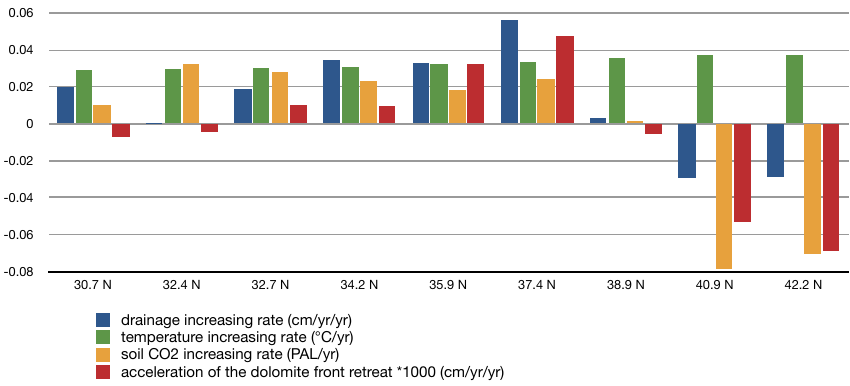
Fig. 8. Increasing rates of vertical drainage (below the root zone), ground temperature, and soil CO 2 level over the Mississippi transect, simulated for the 1950–2100 period. In red, acceleration of the dolomite retreat rate along the transect simulated over the same period. The dolomite front is moving downwards at each location, but this retreat rate either accelerates (positive value) or decelerates (negative value). Maximum acceleration of the retreat rate is reached in the central section of the Mississippi Valley, owing to the rate of change in climatic and geochemical